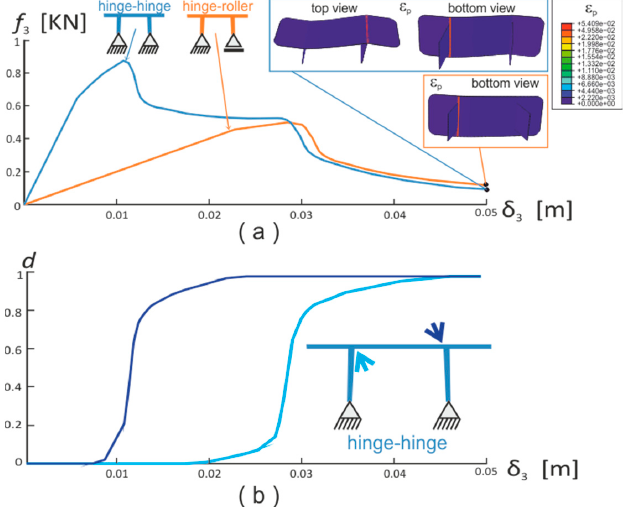
Figure 9. Horizontal loading. ( a ) Force-displacement curves for different boundary conditions, and snapshots of plastic deformation at failure. ( b ) Damage displacement curves evaluated in different points of the table, when hinge-hinge boundary conditions are applied.